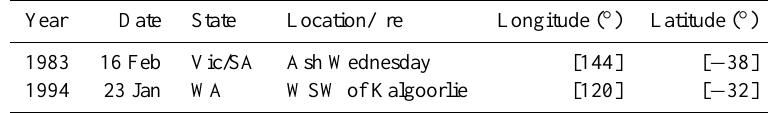
Table A2. List of events in Australia which are currently under investigation as candidates for pyroCb